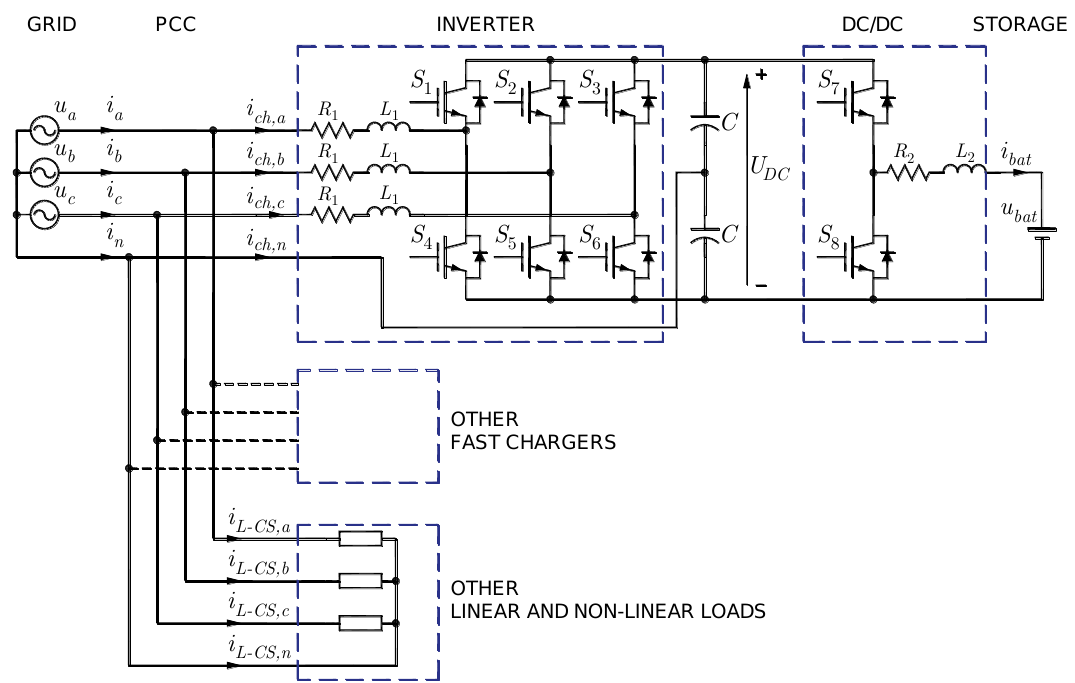
Figure 2 . Three-phase topology for one fast charger and the other charging station facility’s unbalanced and non-linear loads.